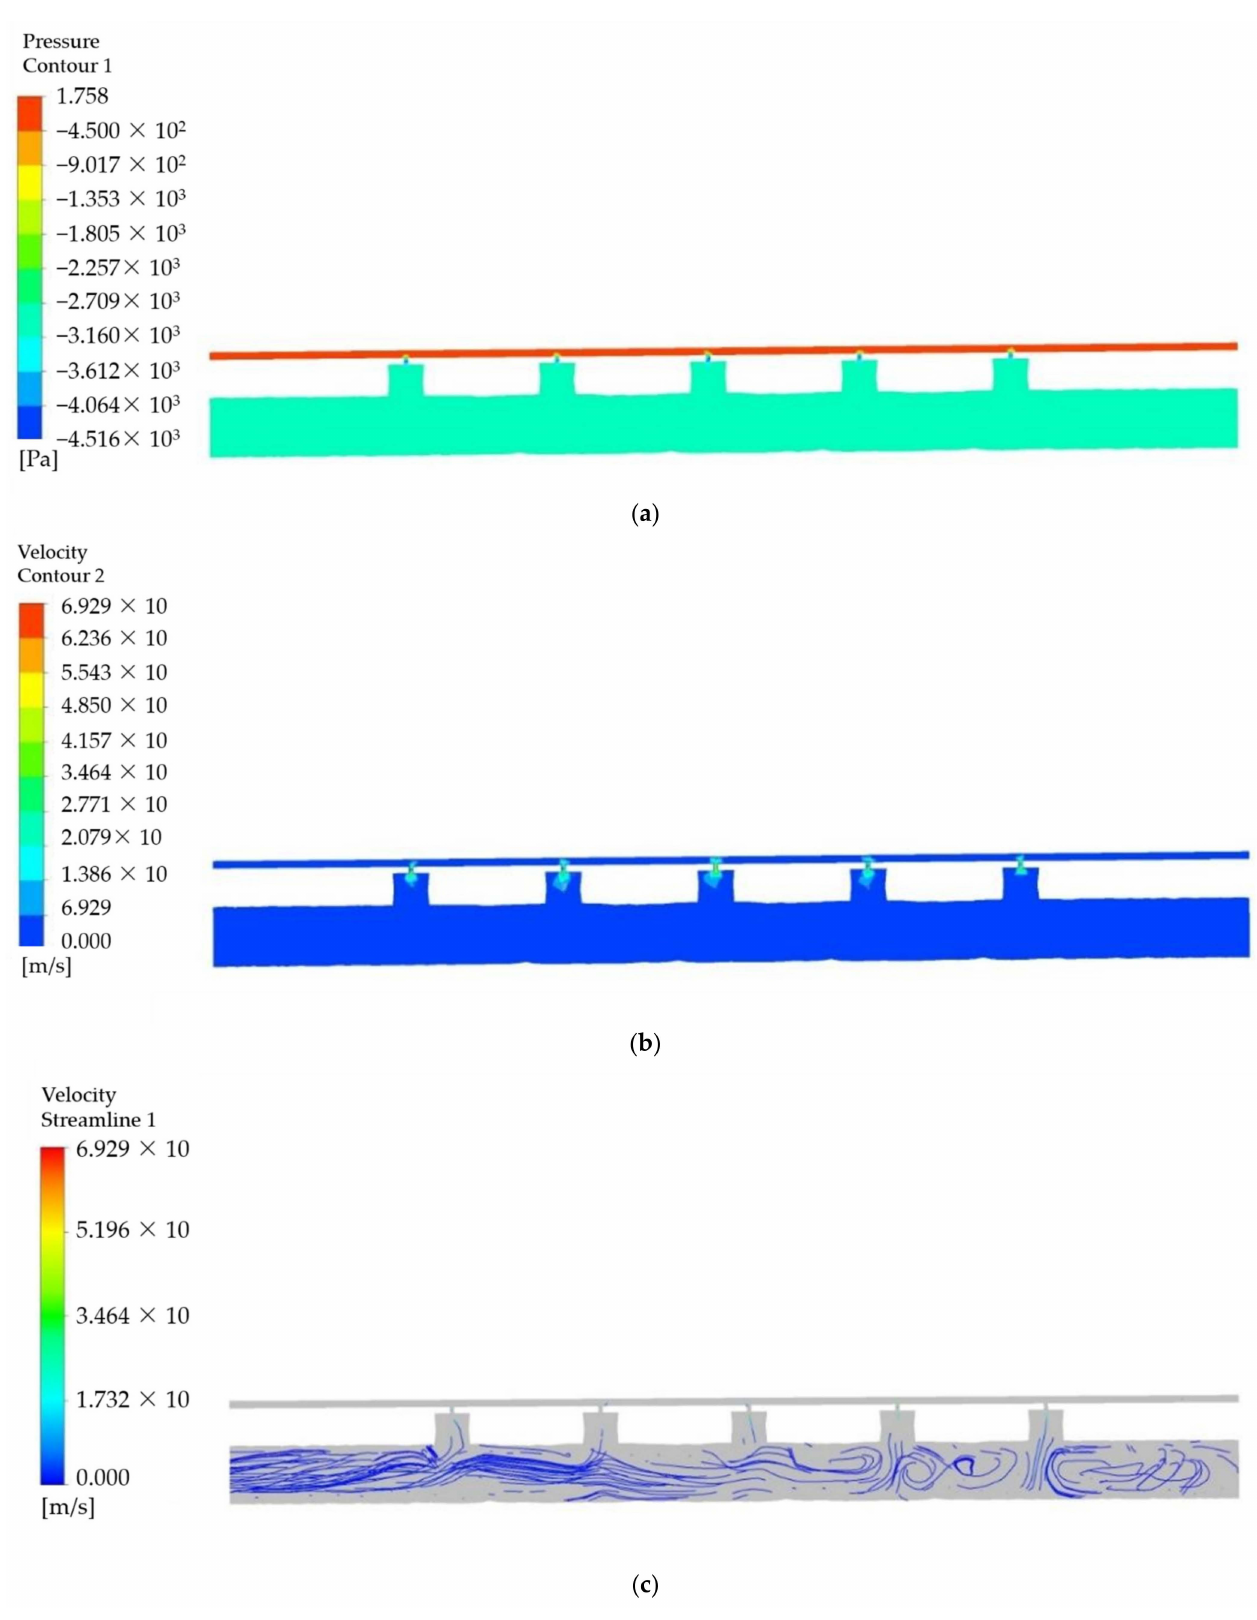
Figure 7. ( a ) The cloud chart of pressure distribution of 1.5 mm; ( b ) The cloud chart of velocity distribution of 1.5 mm hole; ( c ) The streamline diagram of velocity of 1.5 mm